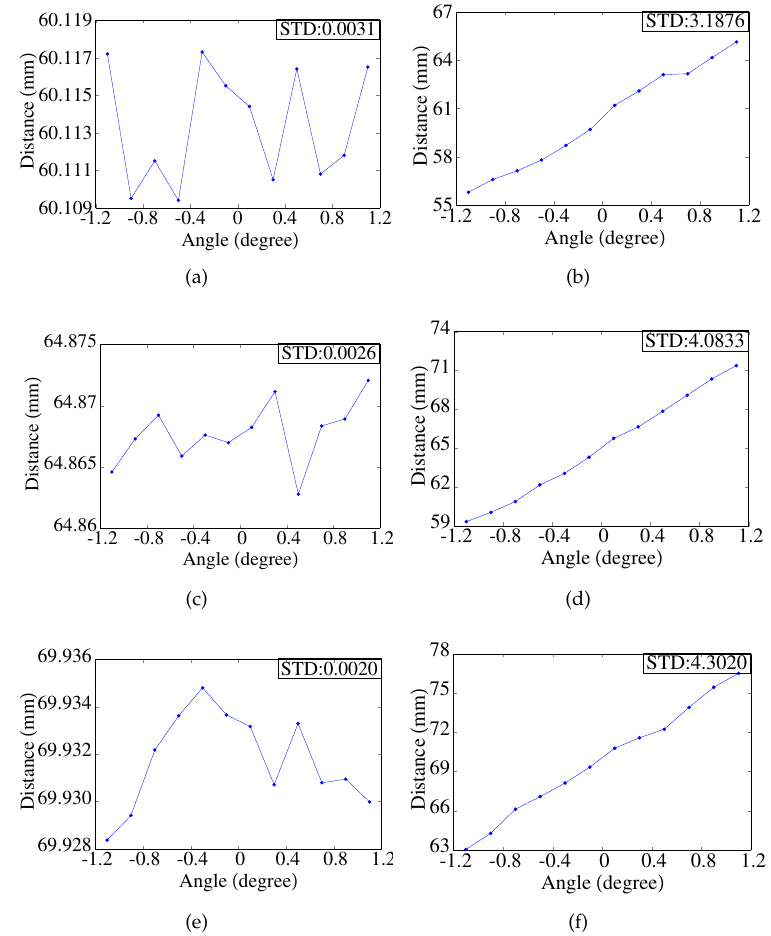
Figure 10. ( a )Repeatability with laser beam pointing control when the object is located at a closer point; ( b ) Repeatability without laser beam pointing control when the object is located at a closer point; ( c ) Repeatability with laser beam pointing control when the object is located at zero point; ( d ) Repeatability without laser beam pointing control when the object is located at zero point; ( e ) Repeatability with laser beam pointing control when the object is located at a farther point; ( f ) Repeatability without laser beam pointing control when the object is located at a farther